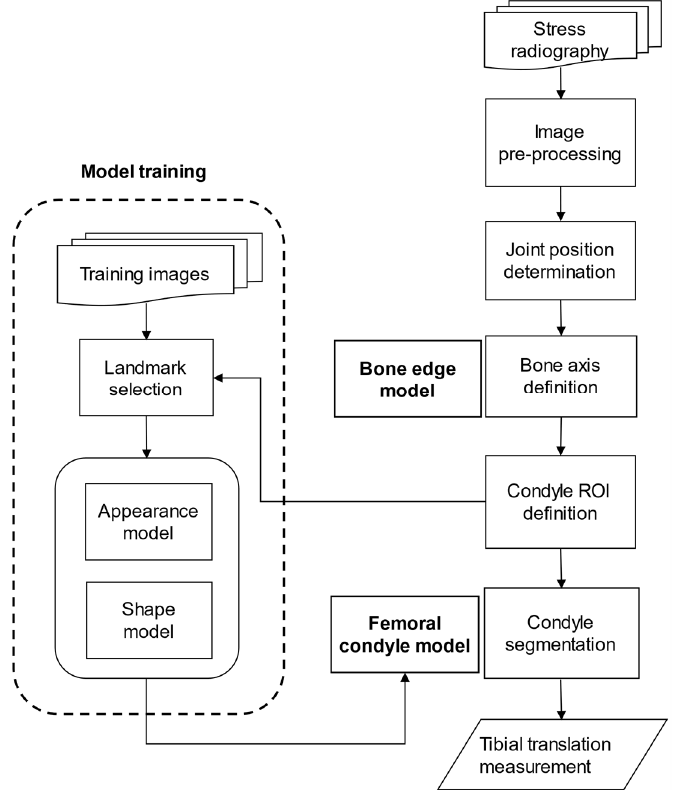
Figure 2. The flow chart of knee segmentation.